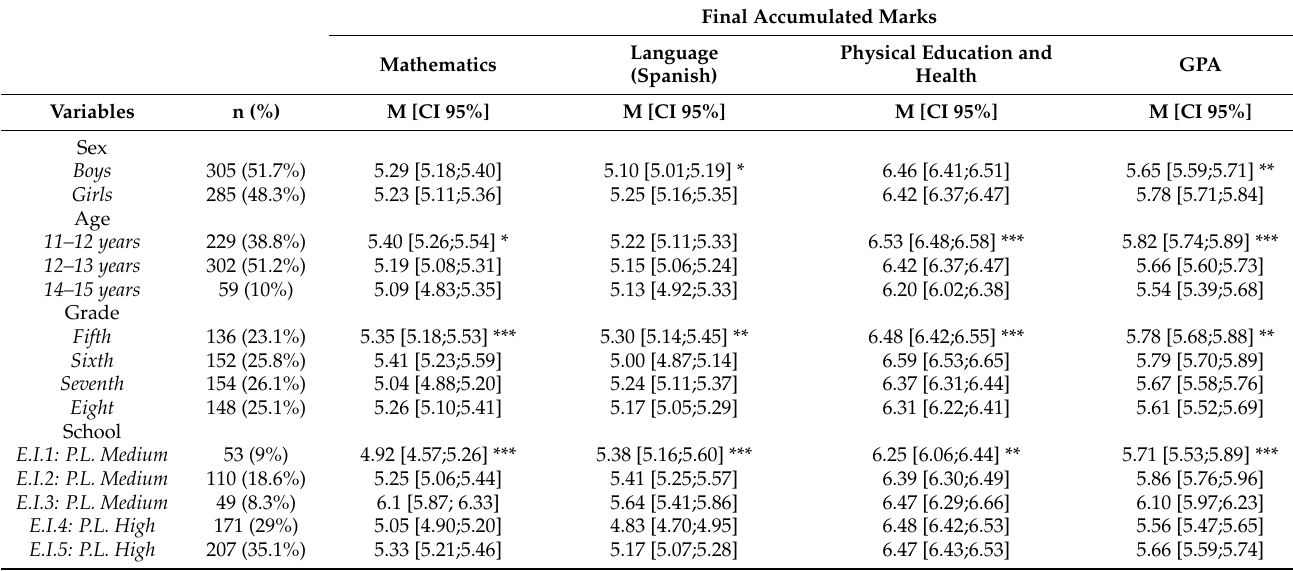
Table 1. Socio-educational characteristics of analyzed students.